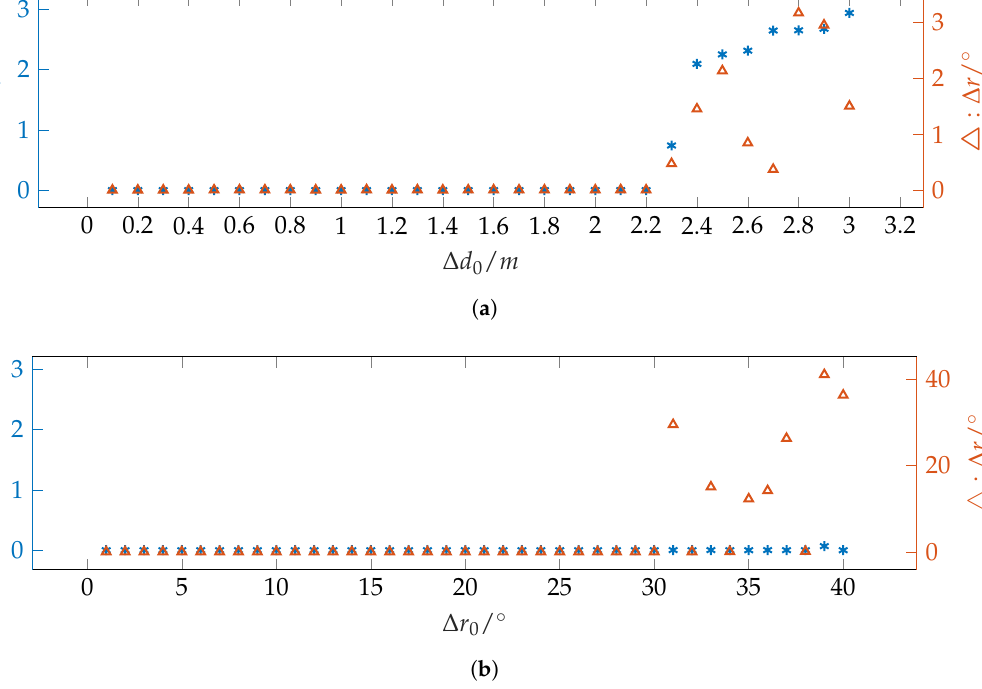
Figure 4. Required accuracy of the initial calibration parameters (( a ): Initial translation, ( b ): Initial rotation). Up to an initial translation error of 2.2 m or an initial rotation error of 31 ◦ the results are in the range of sub-millimeters and sub-degrees. More inaccurate values for the initial calibration parameters mean that the optimization no longer converges to the global minimum and the errors clearly